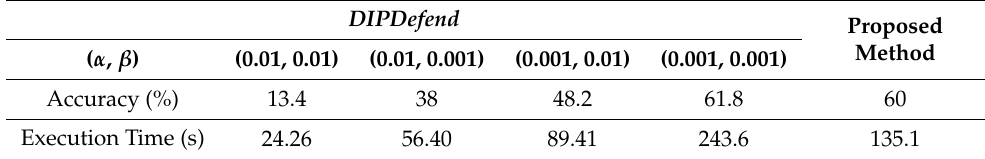
Table 13. Execution time and accuracy of DIPDefend and the proposed method when (cid:101) = 8.